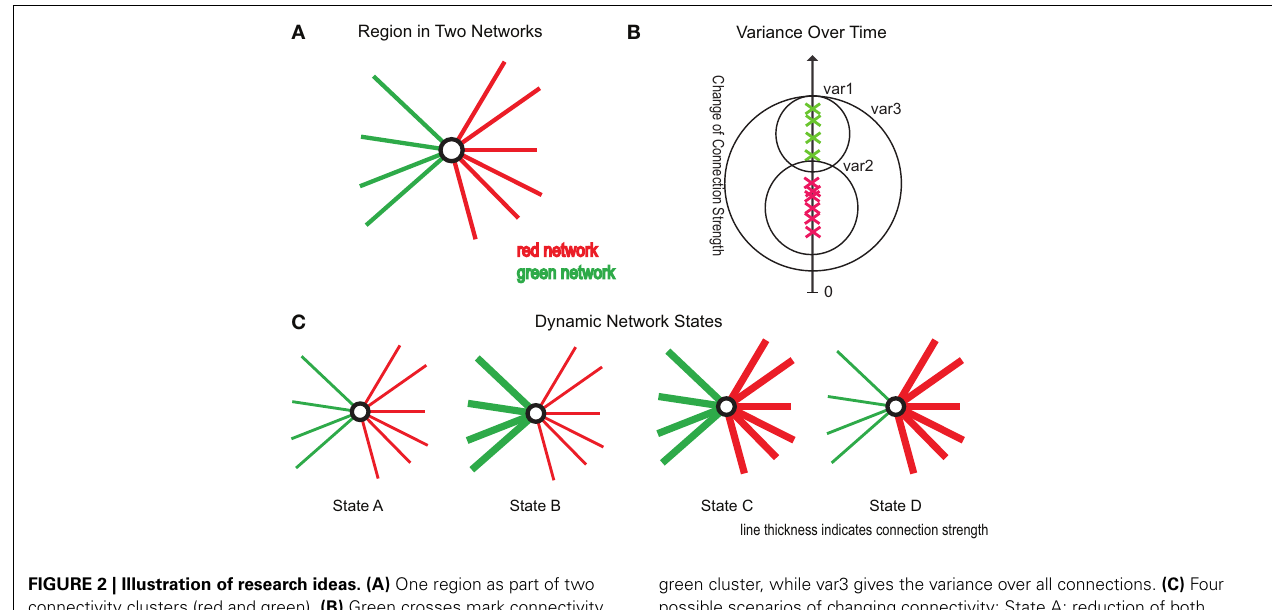
green cluster, while var3 gives the variance over all connections. (C) Four possible scenarios of changing connectivity: State A: reduction of both clusters, State B: reduction of red cluster and increase of green cluster, State C: increase of both clusters, and State D: reduction of green cluster and increase of red